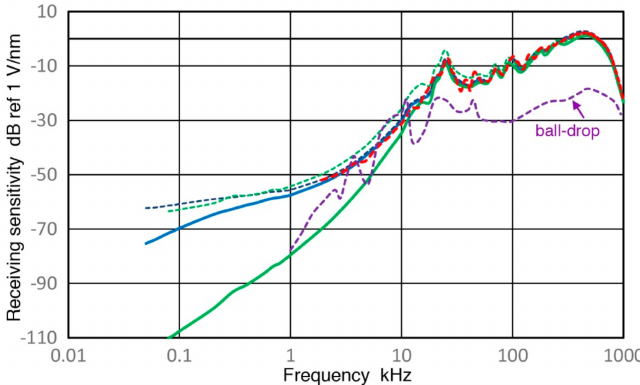
Figure 11. Receiving displacement sensitivity spectra are shown against log-frequency (in kHz) for V101 (0.5) transducer in dB in reference to 1 V/nm using two Z in of 1 M Ω (blue) and 10 k Ω (green) and 380 Ω (purple). Corresponding pulse sensitivity spectrum is in red dash curve and calculated open-circuit sensitivities are in blue dot (using data of Z in of 1 M Ω ) and in green dot (10 k Ω ) curves. A spectrum obtained by a ball-drop method is plotted for comparison in purple